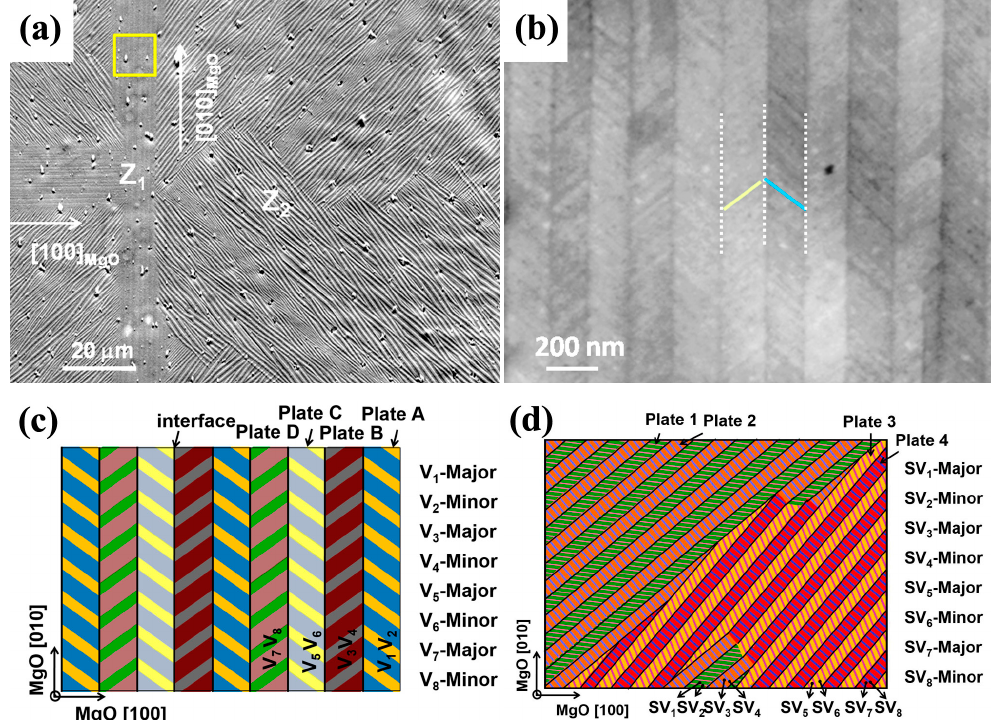
Figure 15. ( a ) SE image of electrolytically polished Ni-Mn-Ga thin films, showing NM martensite plates that are clustered in colonies with low (Z 1 ) and high (Z 2 ) relative contrasts; ( b ) high-magnification BSE image of the squared area in Z 1 of Figure 15a, showing fine lamellae distributed alternately inside each plate; ( c ) illustration of the geometrical configuration of NM variants in Z 1 zone; and ( d ) illustration of the geometrical configuration of NM variants in Z 2 zone [63].